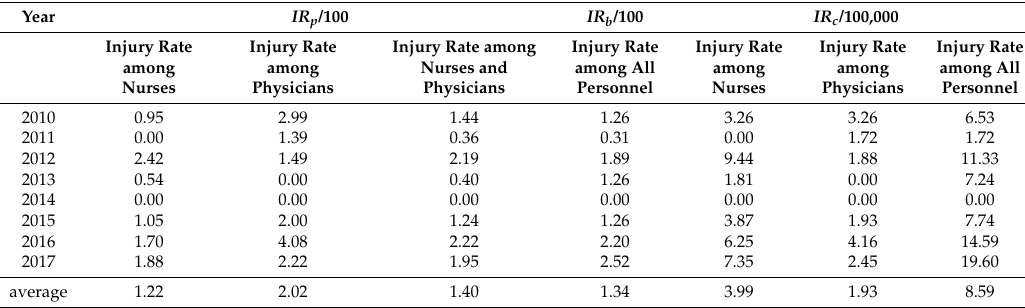
Table 3. Injury rates IR p , IR b , IR c by years among